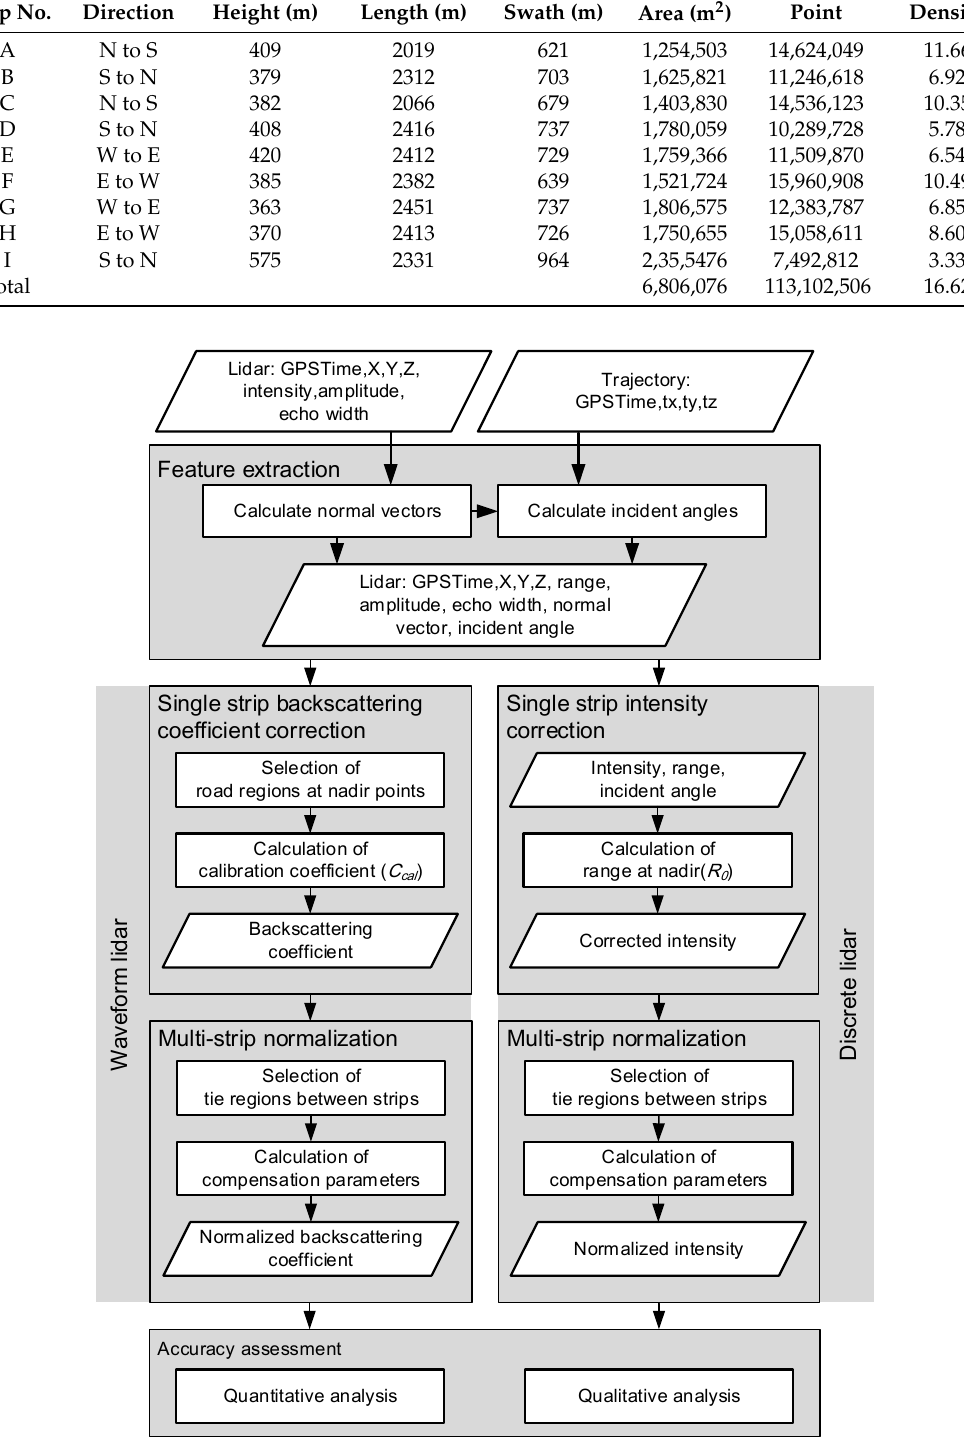
Figure 3. The workflow of multi-strip radiometric normalization.